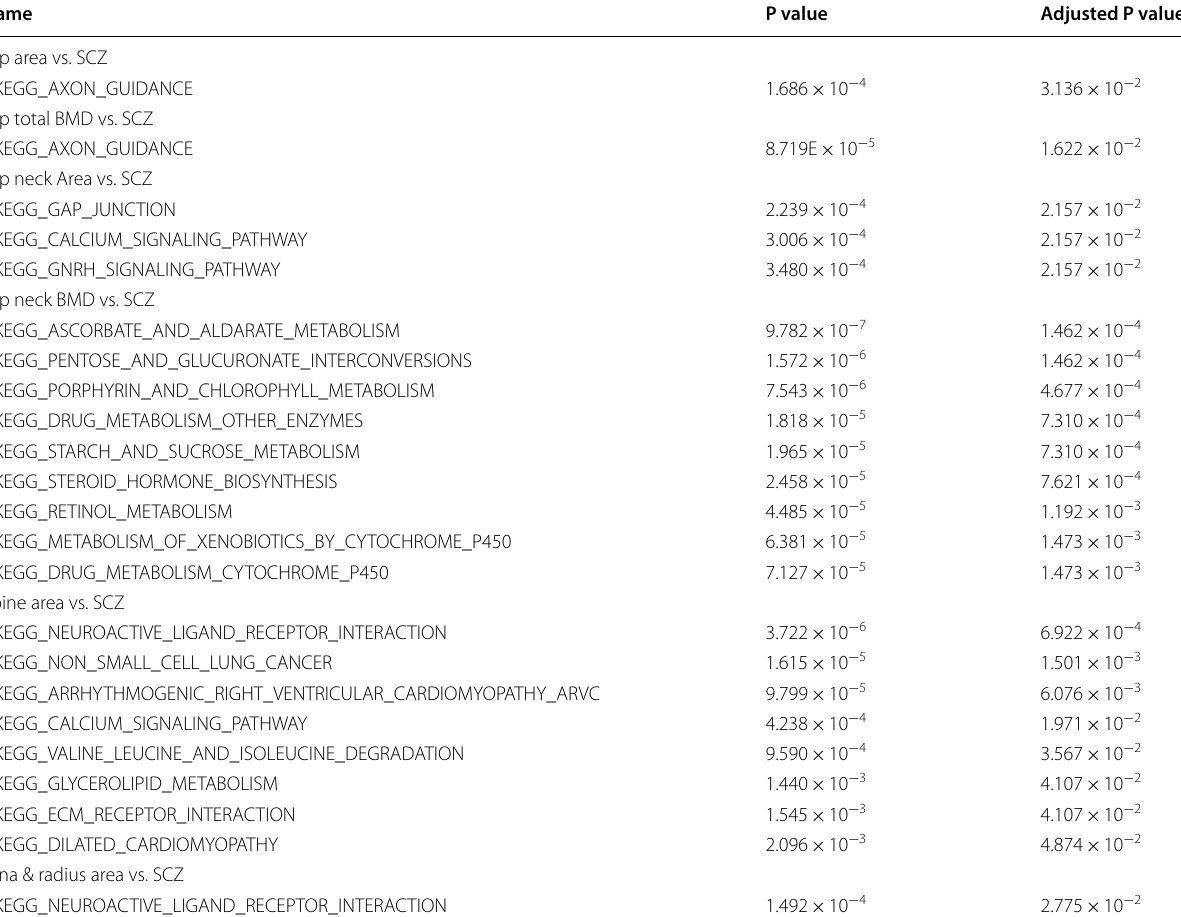
Table 3 FUMA gene set enrichment analysis results of KEGG pathways for identified associations (Adjusted P value <